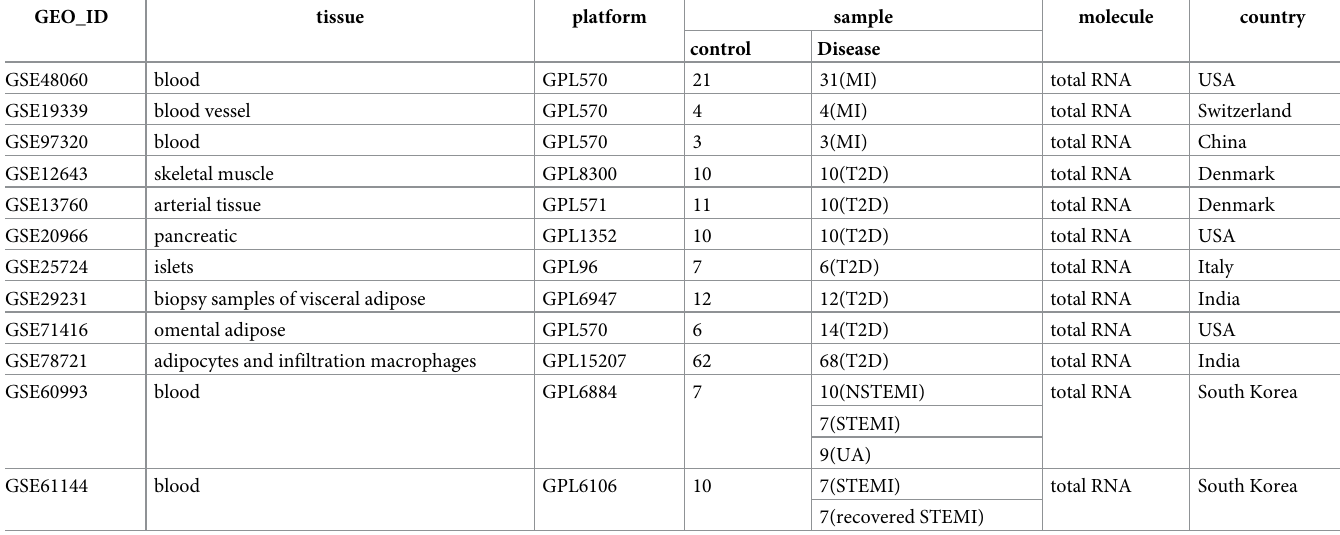
Table 1. Information of the dataset used for the